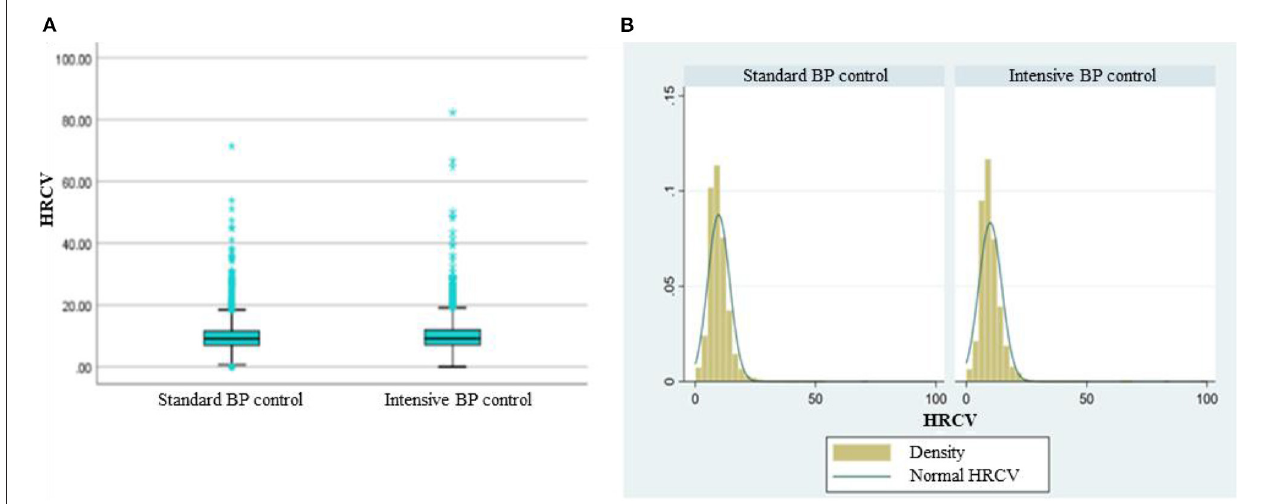
FIGURE 1 | The distribution of HRCV according to treatment arms. (A) Box plot of HRCV grouped by standard and intensive BP control. No significant difference between the two groups by Mann-whitney U- test ( P = 0.052). (B) Density curve of HRCV grouped by standard and intensive BP control. Normal HRCV: normal distribution curve of HRCV.